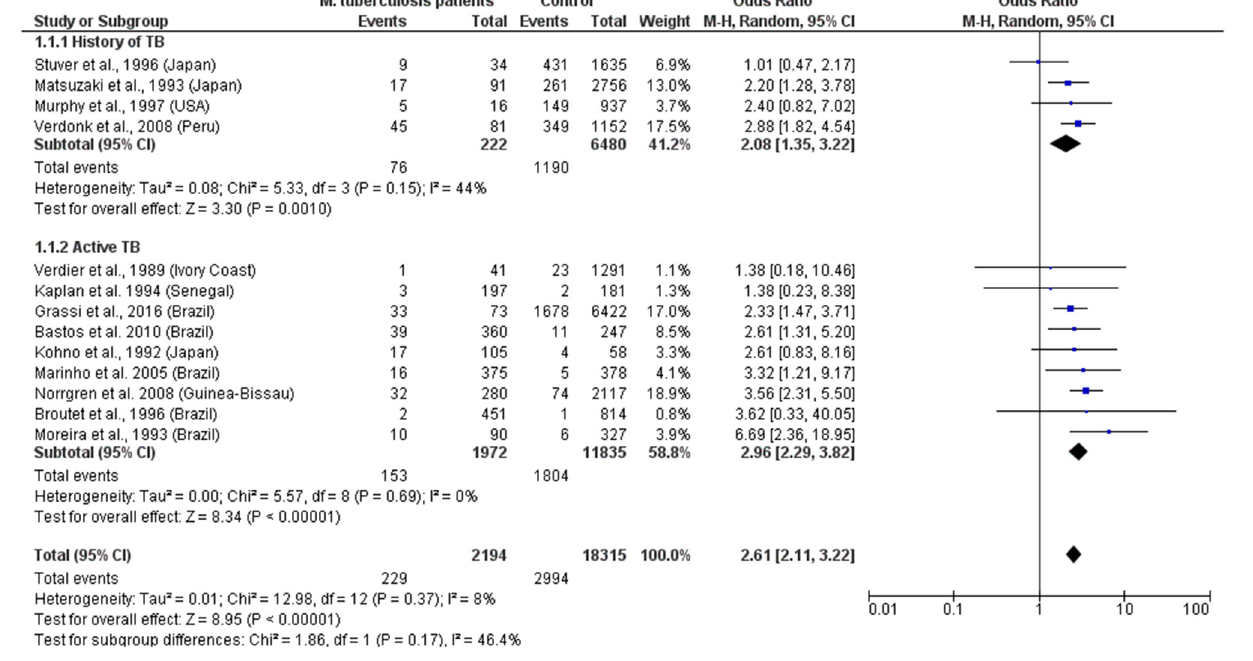
FIGURE 1 | Forest Plot and meta-analysis showing the Odds Ratio of HTLV-1 infection in patients with Mycobacterium tuberculosis . The boxes and lines indicate the odds ratios (ORs) and their confidence intervals (CIs) for each study. The pooled odds ratio is represented by a black diamond. The size of the blue squares indicates the relative weight of each estimate. Statistical analysis and graph were performed using RevMan 5 Software. Odds Ratio was calculated using Random effects model and Mantel-Haenszel statistical method. Measures of heterogeneity between studies in each subgroup (those with History of TB and those with Active TB) and between subgroups is